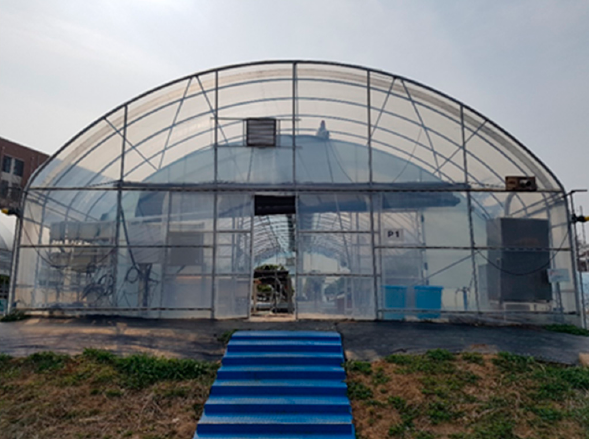
Figure 1. Experimental greenhouse at Daegu (latitude 35.53 ◦ N, longitude 128.36 ◦ E).